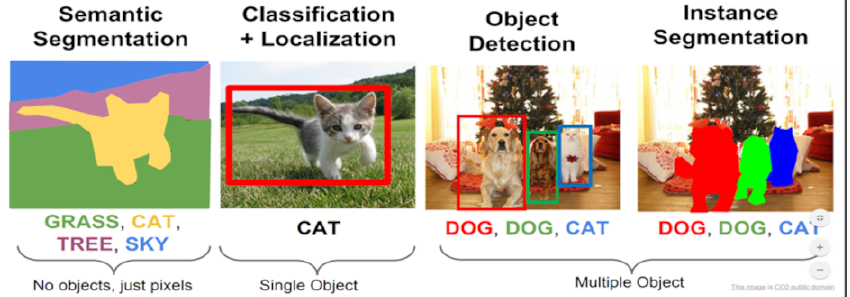
Figure B1. Region group concept from https://data-flair.training/blogs/image-segmentation-machine-learning/ (last access: 1 November 2021).